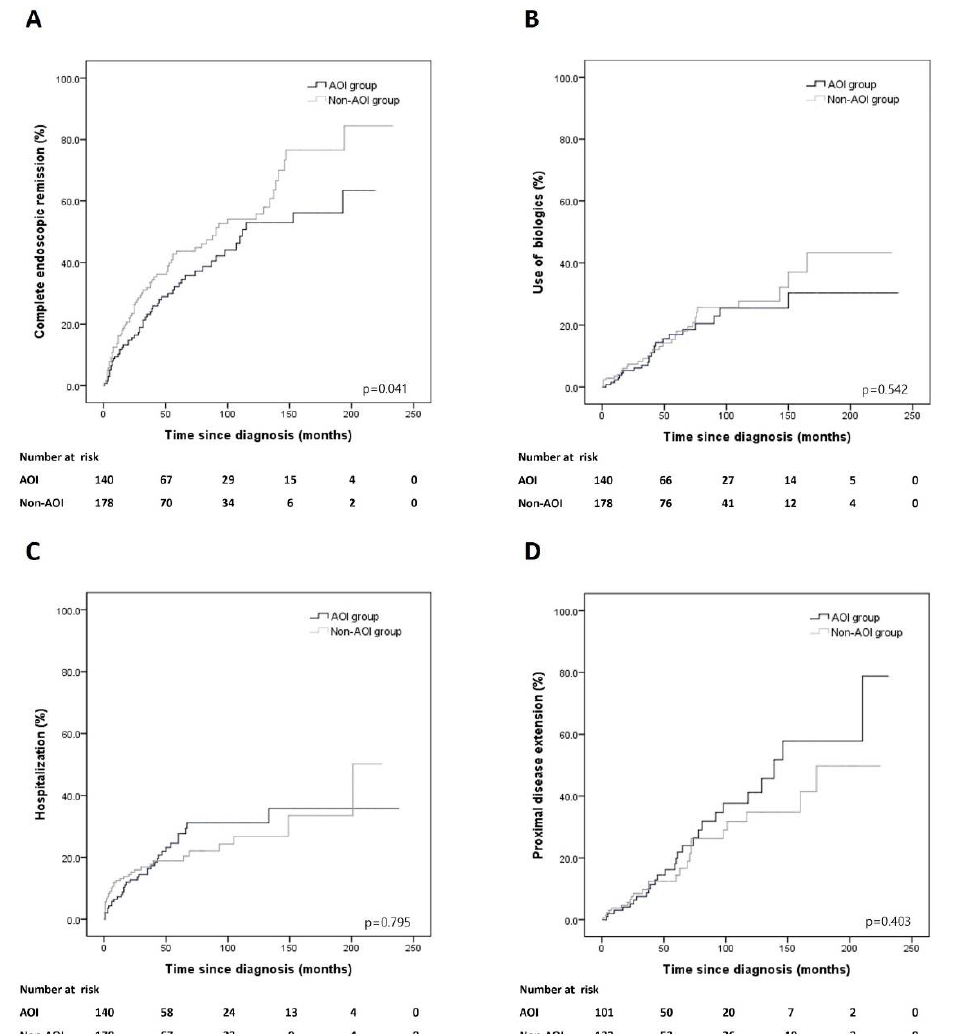
Figure 1. Cumulative risks of outcomes in patients with AOI and non-AOI groups. ( A ) Complete endoscopic remission, ( B ) use of biologics, ( C ) hospitalization, ( D ) proximal disease extension.